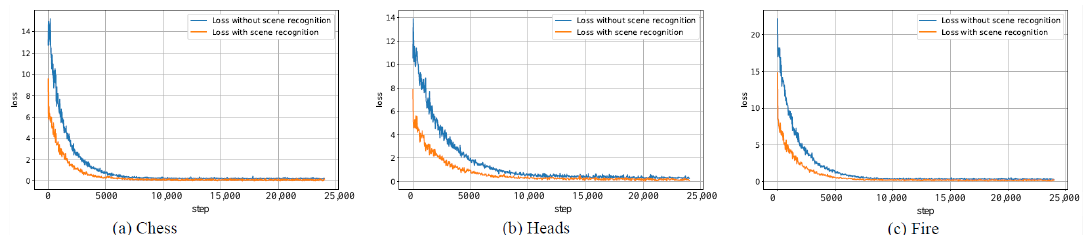
Figure 4. Relocalization loss of two networks.This demonstrates that the network with scene recognition is better than the network without scene recognition.